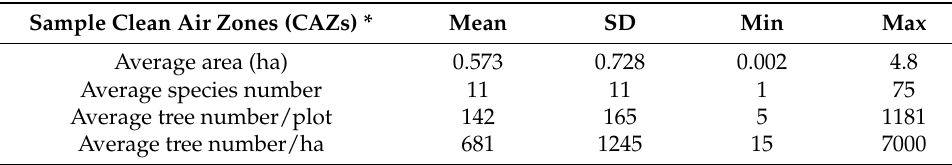
Table 1. Description of areas and number of trees planted in the sample plots.